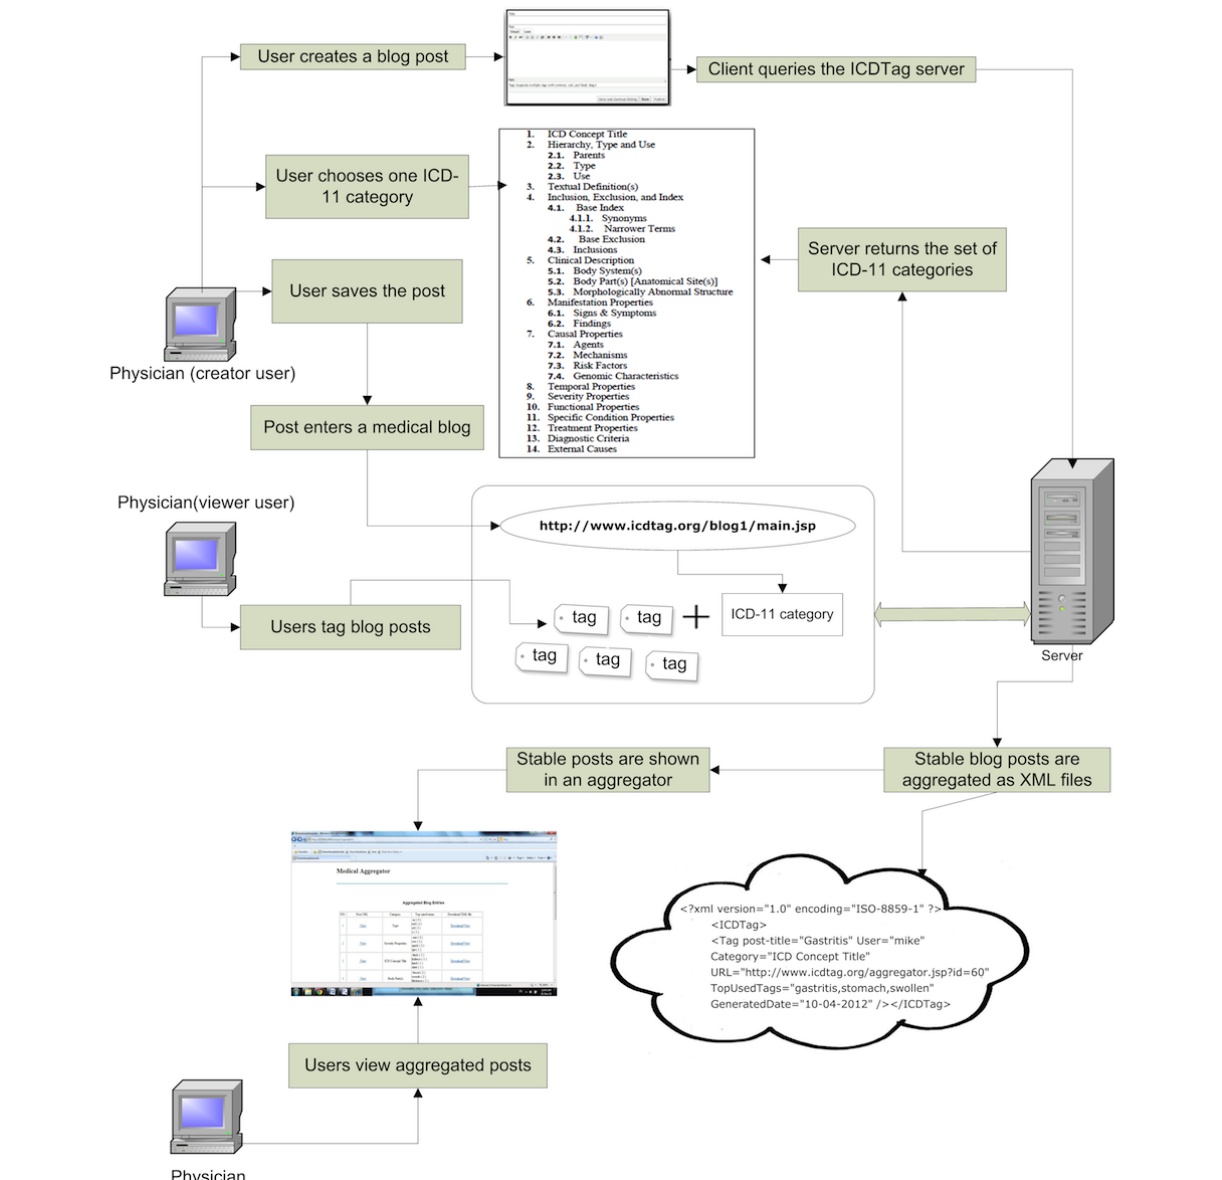
Figure 5. The detailed architecture of